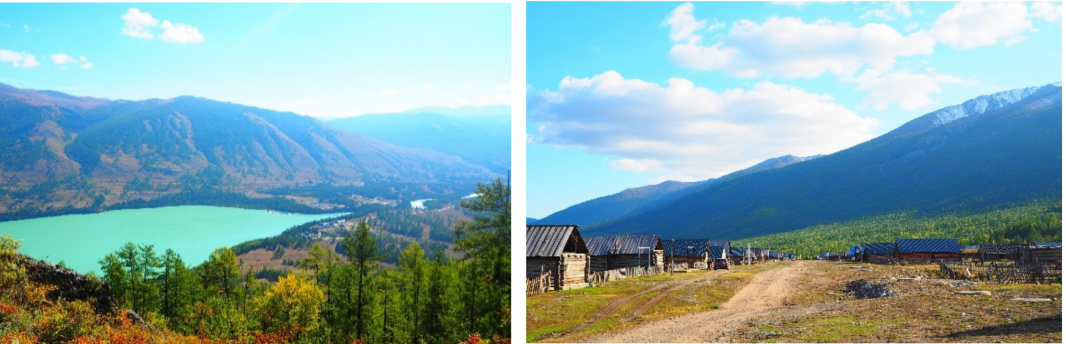
Figure 2. Kanas Lake and cabins of Kanas National Forest Park in Xinjiang province, China. (Pho- tographed by the first